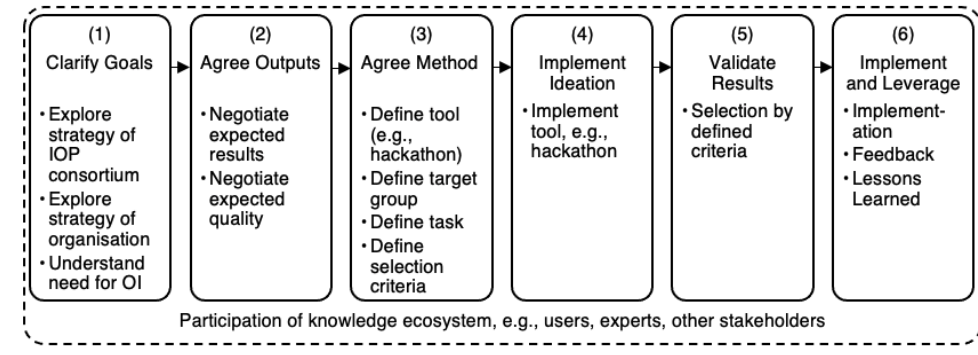
Figure 3. Initial Open Innovation process for inter-organizational